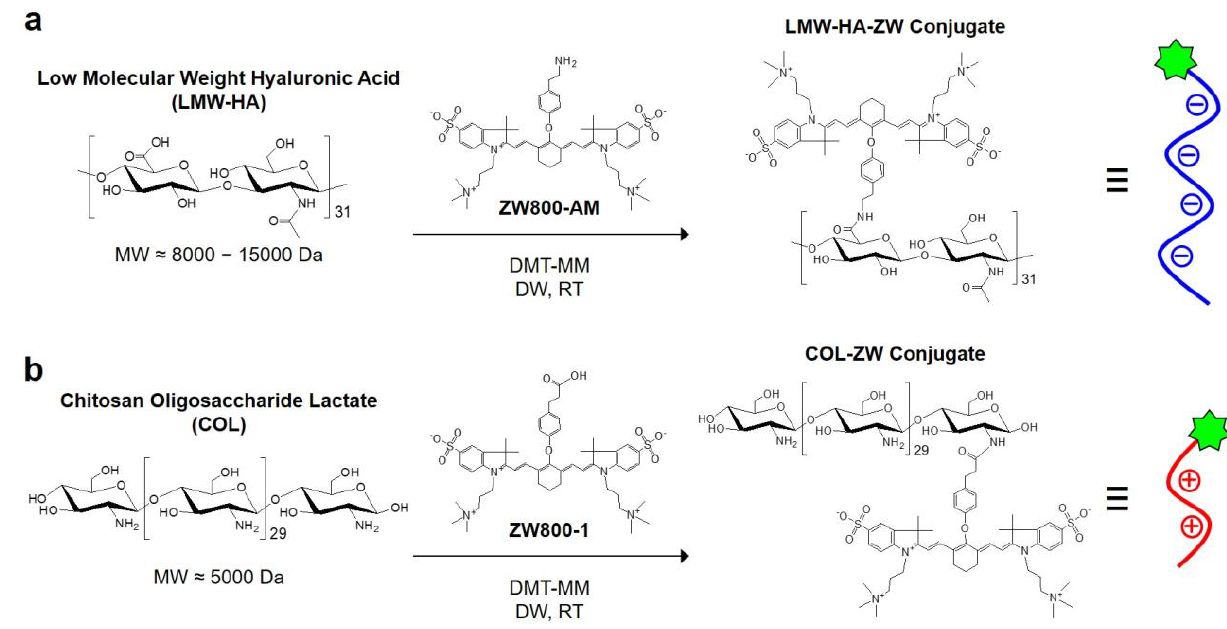
Figure 1. Synthetic scheme of ( a ) LMW-HA-ZW and ( b ) COL-ZW conjugates for NIR fluores- cence